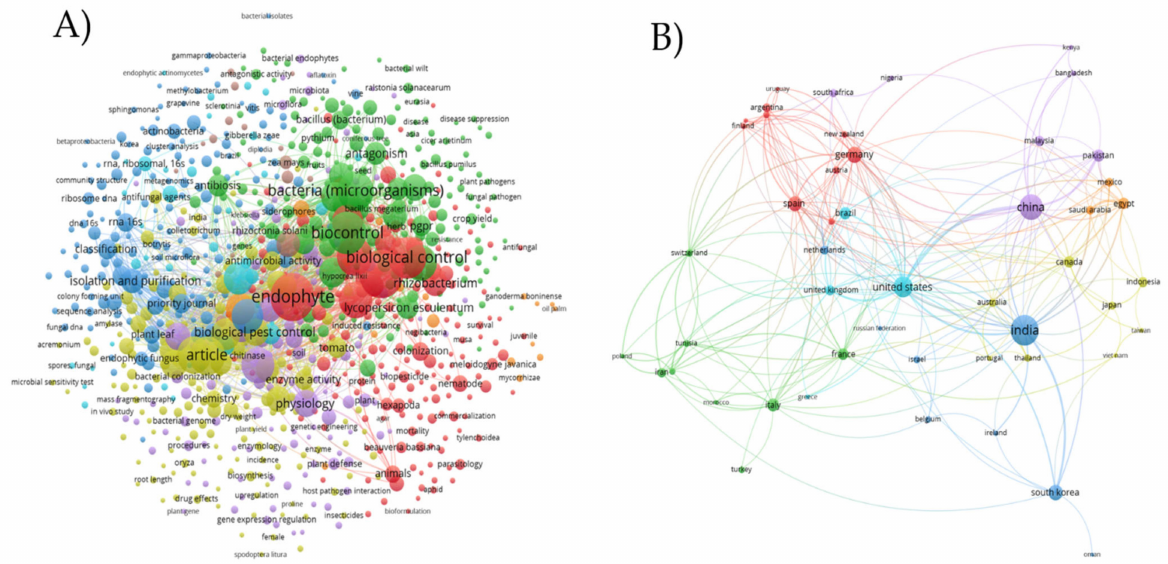
Figure 1. Bibliometric analysis of 1150 articles published on biological control according to the Scopus database using specific keywords such as “Rhizobacteria” OR “Endophytes” OR ”Biocontrol” ( A ) and the network analysis of their worldwide distribution ( B ); the larger the circle, the more intense the scientific